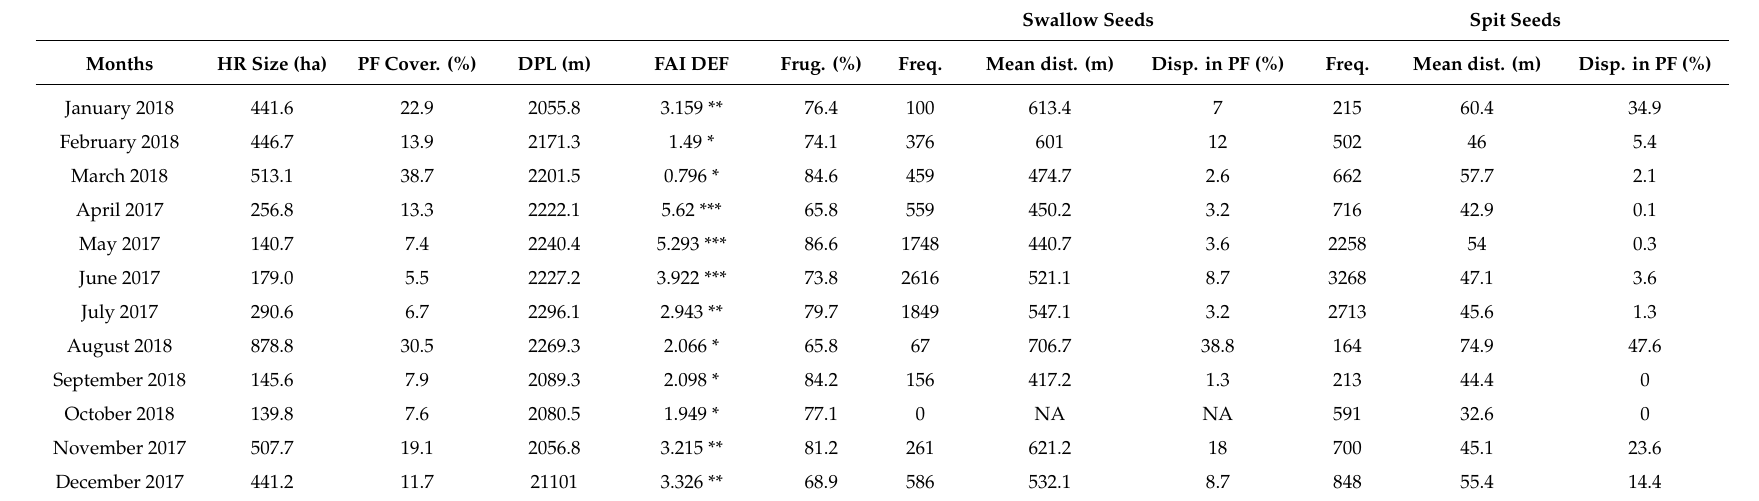
Table 1. Total monthly home range (HR) size with plantations (PF) coverage (cover.) percentage, monthly Food Abundance Index (FAI) calculated for the Dry-evergreen Forest (DEF), monthly macaque frugivory (Frug.), that is, fleshy and dry fruit consumption, simulated monthly daily path length (DPL) with MOST and total monthly dispersal kernel results for swallowed and spat out seeds: frequencies (freq.), mean distances (dist.) and proportions of dispersed (disp.) seeds in plantation forests (PF). Swallow Seeds Spit Seeds Months HR Size (ha) PF Cover. (%) DPL (m) FAI DEF Frug. (%) Freq. Mean dist. (m) Disp. in PF (%) Freq. Mean dist. (m)